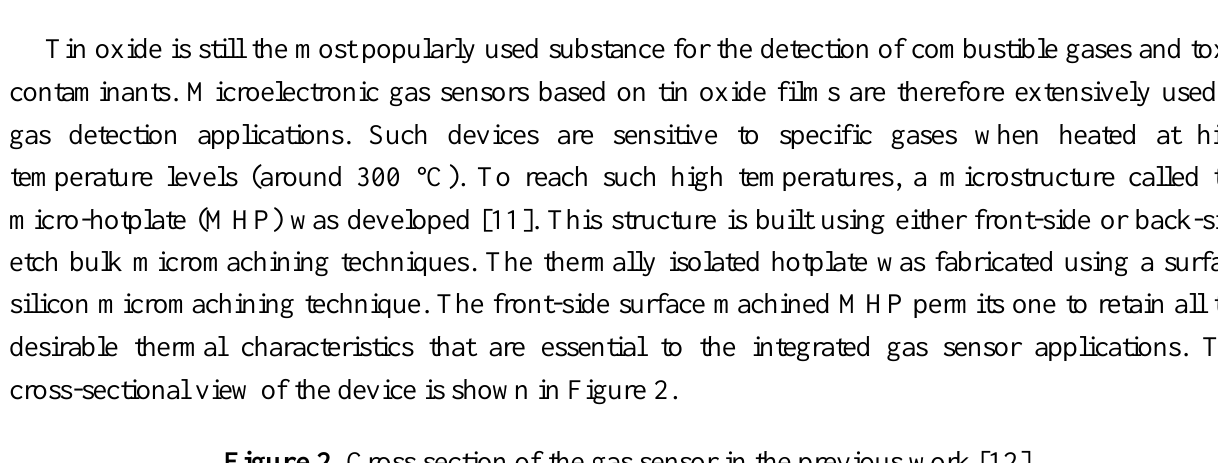
Figure 2. Cross section of the gas sensor in the previous work